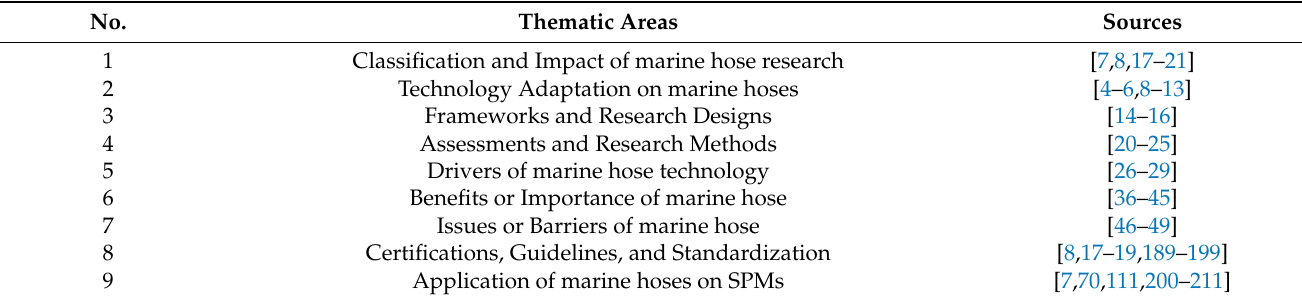
Table 3. Thematic area for research trend on marine